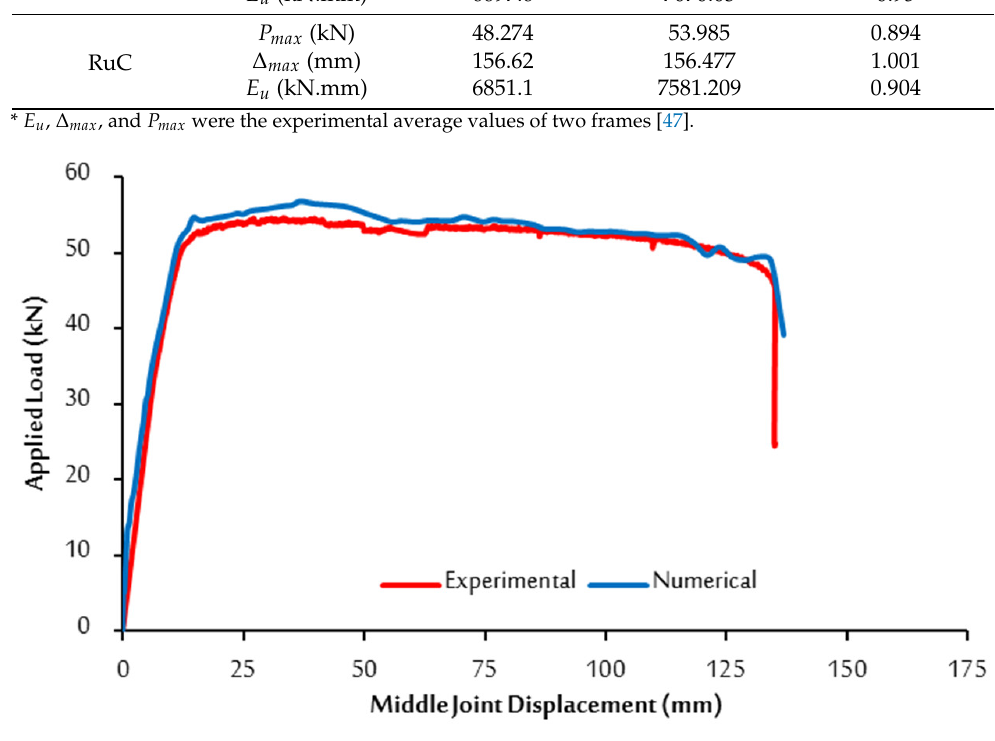
Table 8. Comparison of experimental and numerical load–displacement properties for the tested frames.